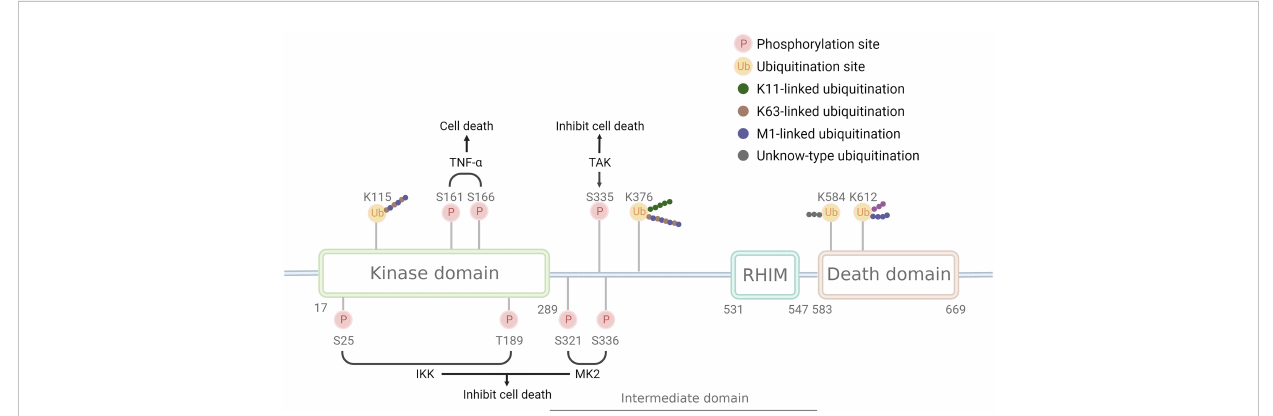
FIGURE 1 Structure and modi fi cation sites of RIPK1. RIPK1 comprises the N-terminal kinase domain, the C-terminal death domain that mediates death signaling, the bridging intermediate domain, and the RIP homotypic interaction motif (RHIM). Phosphorylation sites have two opposite effects: S161 and S166 have a pro-death effect and are phosphorylated after TNF- a stimulate, while S25, T189, S321, S335, and S336 have a pro-survival effect and are phosphorylated by IKK, MK2, and TAK. Ubiquitination sites can be linked by different Ub chains: K115 can be linked by K63 and M1 chain, K376 linked by K11, K63, and M1 chain, K612 linked by M1 chain, while K584 remains unknown. Pink circle with P indicates phosphorylation sites, a yellow circle with Ub indicates ubiquitination sites, green dots indicate K11 ub chain, brown dots indicates K63 ub chain, purple dots indicate M1 ub chain, grey indicates unknown ub